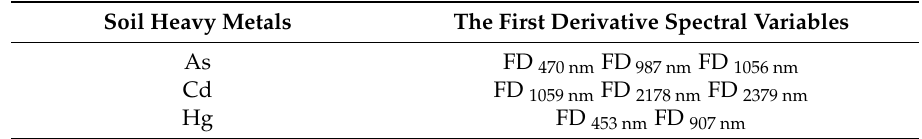
Table 2. The optimal relevant spectral variables for estimation of three soil heavy metal contents.